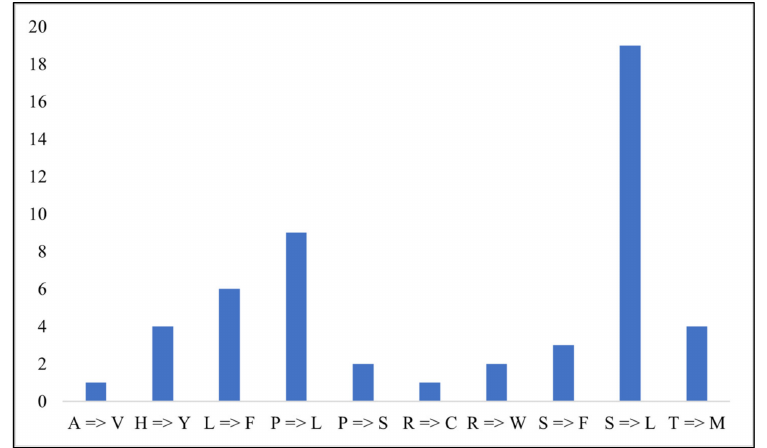
Figure 6. The frequency of amino acids conversions in the Ficus populifolia plastome. A = Ala; V = Val; H = His; L = Leu; F = Phe; P = Pro; S = Ser; R = Arg; C = Cys; W = Trp; T = Thr; M = Met.